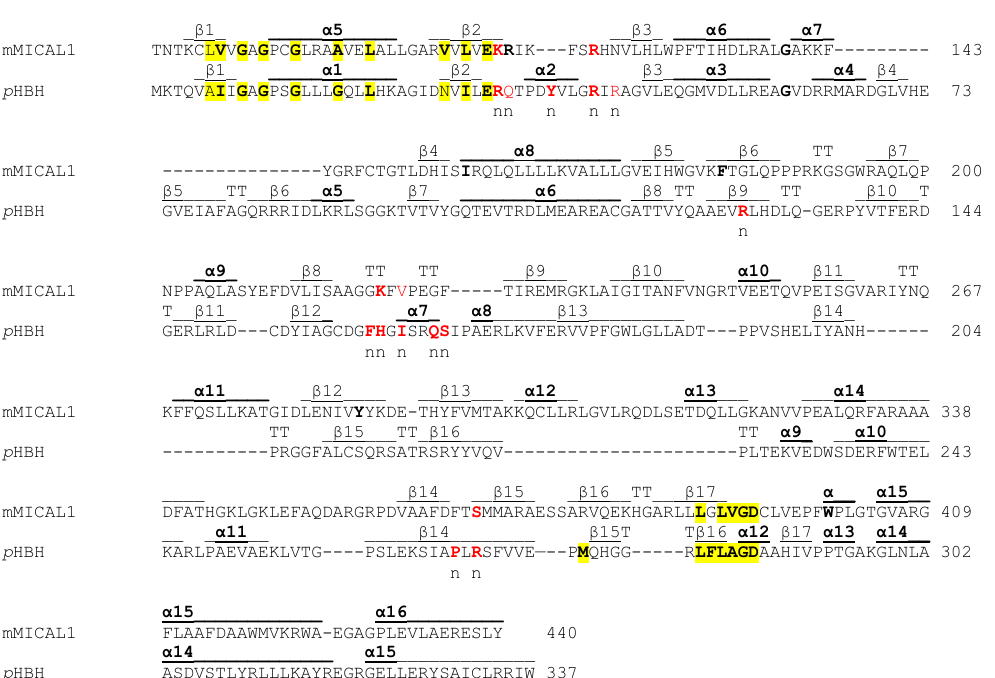
Figure 5. Comparison between mouse MICAL and p-hydroxybenzoate hydroxylase. The 83–440 region of mouse MICAL1 is compared with full-length Pseudomonas fluorescens p -hydroxybenzoate hydroxylase. The alignment takes into account the known three-dimensional structures of the proteins (2BRA [4], 2BRY [3] for mouse MICAL; 1PBE [68] for PHBH) as in [3,4]. The secondary structure elements ( β strands, α helices and β turns (TT) are indicated above each sequence. The conserved residues in the consensus sequence for the formation of the binding site of the adenylate portion of FAD [62] and the second FAD consensus sequence of Eggink et al . [63] are colored yellow. The residues that in PHBH are implicated in NADPH binding [64] are indicated in red and with “n”. If they are conserved in equivalent positions in all MICALs (see Figure 4) they are in red in both sequences. Ser368 (conserved as S or C in all MICAL sequences) proposed to be equivalent to Arg269 of PHBH [3] is also